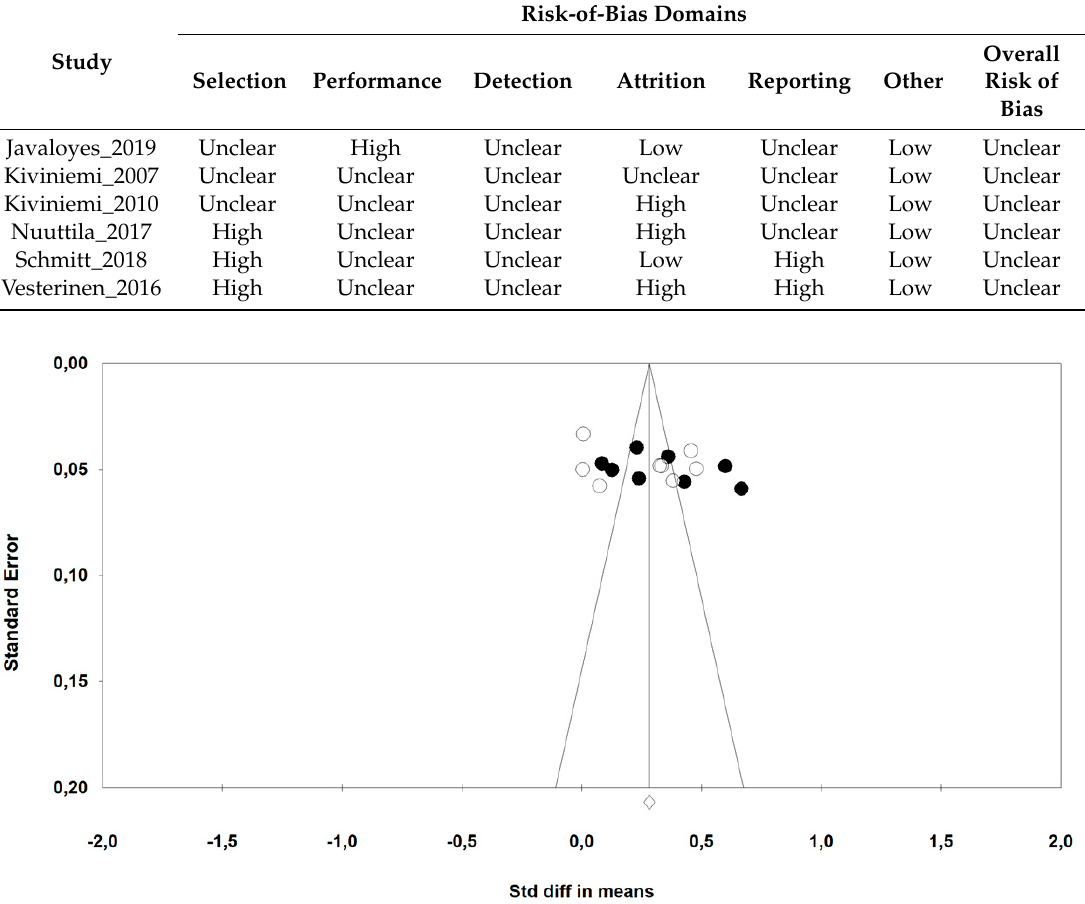
Figure 2. Funnel plot of standard error by standard di ff erences in means (17 comparison; black circle, HRV-guided training; white circle, traditional training).